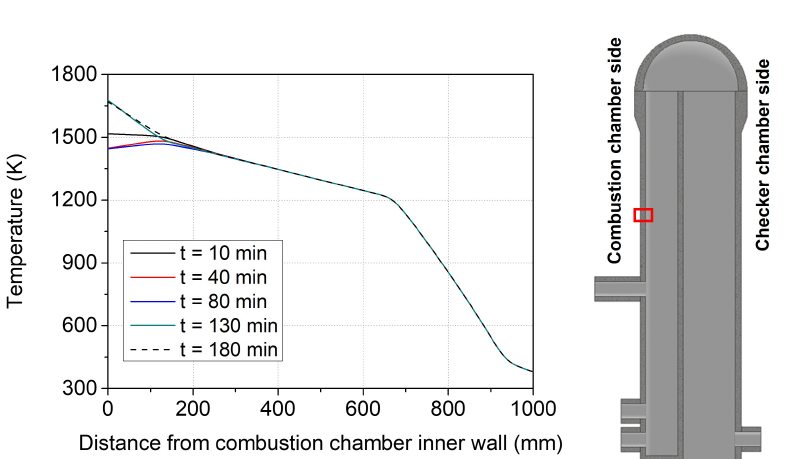
Figure 11. The temperature change in the marked region of the combustion chamber wall through the thickness direction during the operation. The marked region showed the most fluctuating temperature during the